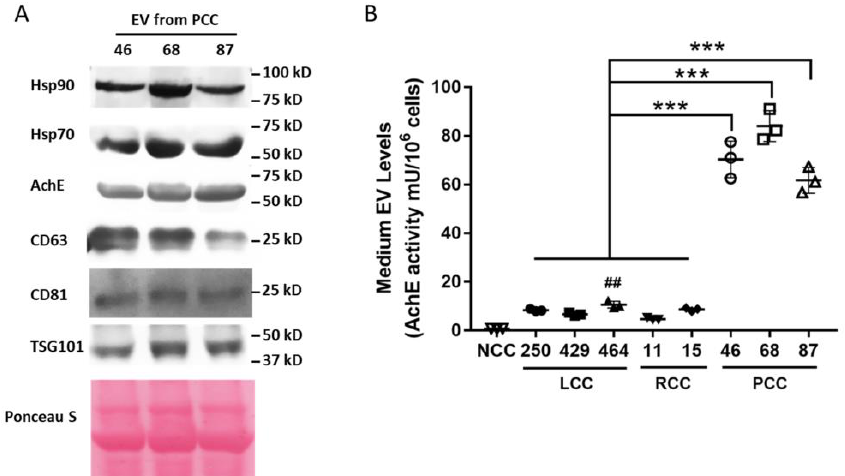
Figure 2. PCC releases markedly higher levels of Hsp70- and Hsp90-carrying EVs than LLC and RCC. ( A ) EVs isolated from PCC-conditioned medium were analyzed for Hsp70/90 and protein markers with Western blotting. ( B ) Hsp70/90-containing EVs were quantified by AchE activity in isolated EVs. Data from 3 independent experiments were analyzed by one-way ANOVA followed by Bonferroni ’ s multiple comparison test. ## denotes difference from NCC at p < 0.01, and *** denotes difference from LCC and RCC at p < 0.001. To determine whether PCC-released Hsp70 and Hsp90 are responsible for activating the p38 MAPK-mediated catabolic pathway in muscle cells, C2C12 myotubes were treated with the conditioned media of PCC, LCC, and RCC to compare their catabolic activity and determine whether neutralizing Hsp70 and Hsp90 antagonizes the catabolic activity of PCC. The conditioned medium of non-tumorigenic human lung endothelial cell line NL20, which does not release an elevated level of Hsp70 and Hsp90 [17], was used as a non-cancer control (NCC). The effect of the neutralizing antibodies on the depletion of